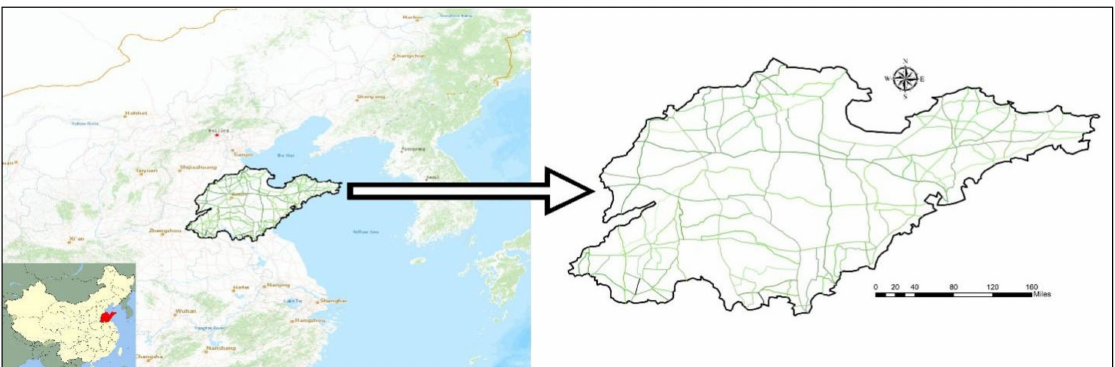
Figure 1. Map of region under